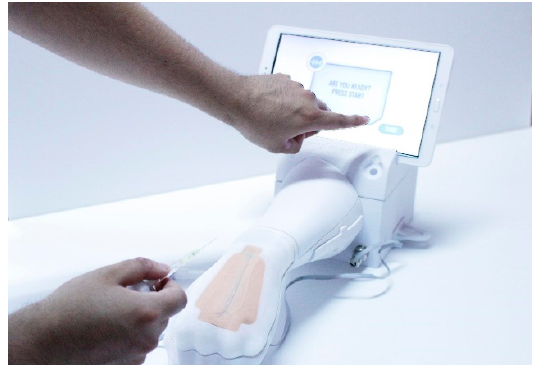
Figure 4. Minimum viable product developed by the team (2019).